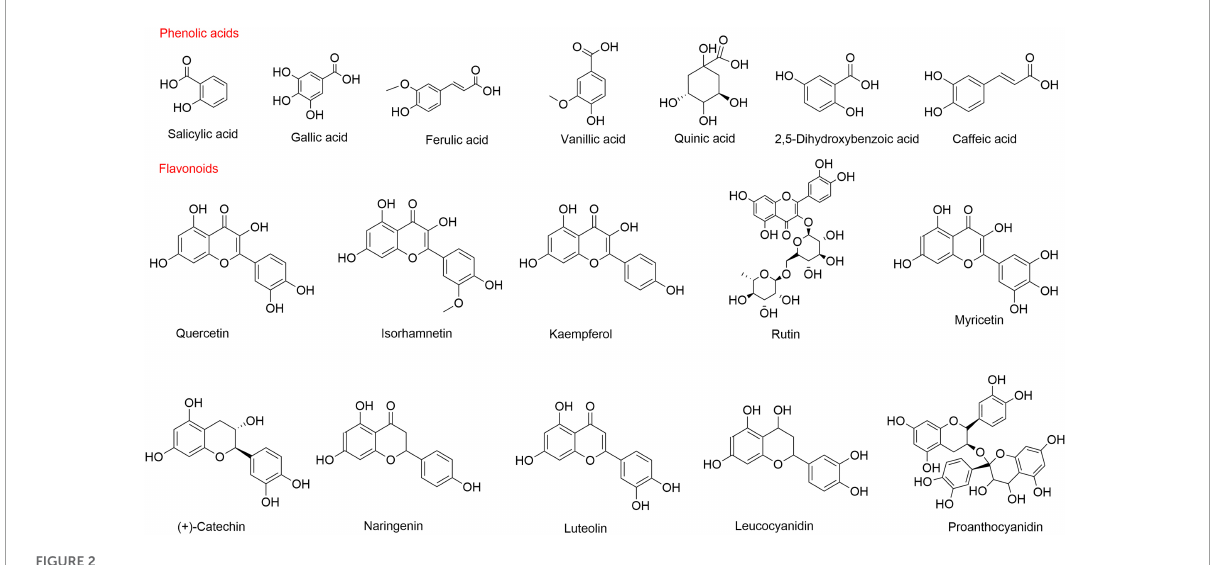
FIGURE2 Structure of the main phenolic compounds in sea